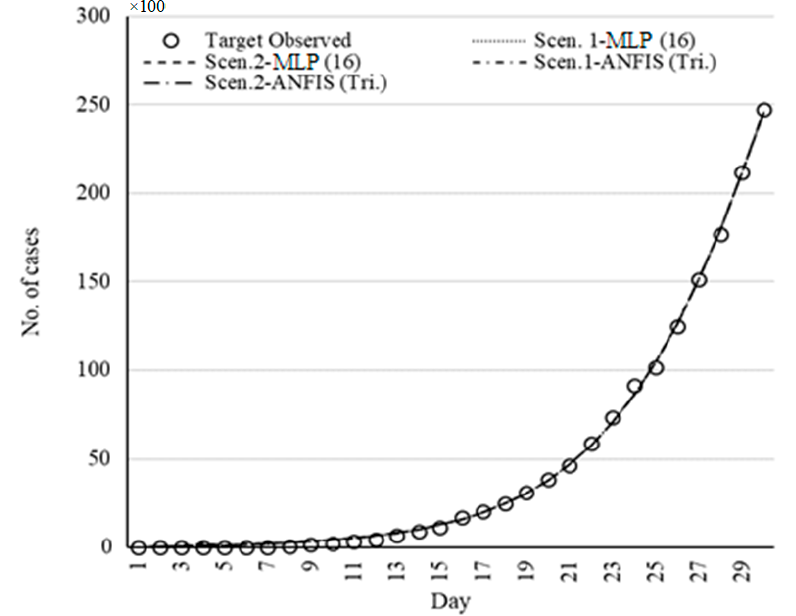
Figure 12. Set of models for Italy fitted by ML methods.